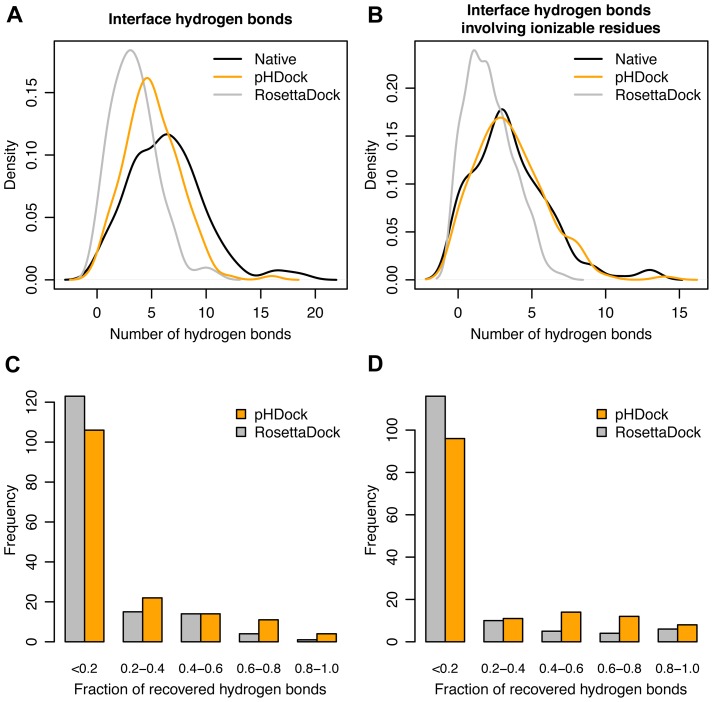
Distributions of native and model interface hydrogen bonds.Kernel density estimate curves for the number of (A) interface hydrogen bonds and (B) interface hydrogen bonds involving ionizable residues in the top-scoring models generated using pHDock (orange) and RosettaDock (grey), and the native crystal complexes (black) across the complete Docking Benchmark dataset. Frequency histograms of the fraction of (C) recovered interface hydrogen bonds and (D) recovered interface hydrogen bonds involving ionizable residues in the top-scoring models.